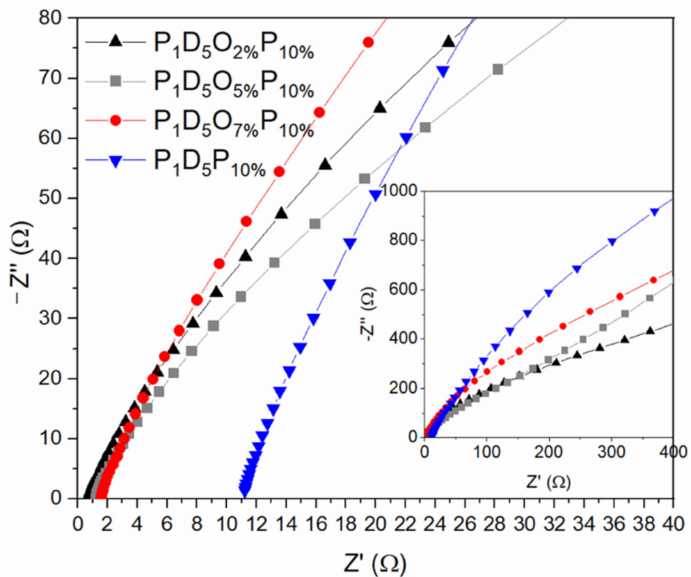
Figure 7. Room temperature impedance diagram of polymer membranes with different OVAPOSS doping amounts.